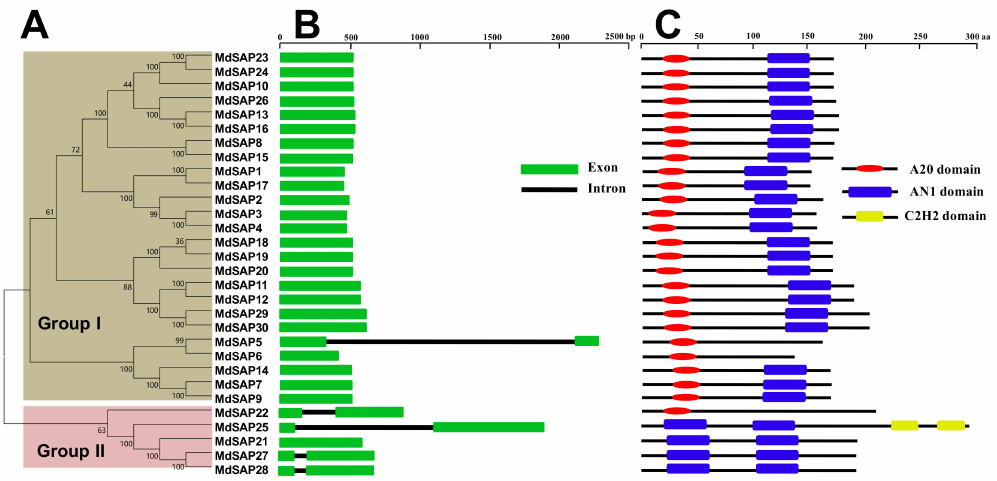
Figure 1. ( A ) Phylogenetic relationships; ( B ) Structures for 30 genes; and ( C ) Analysis of conserved domains for stress-associated protein (SAP) genes in apple. A phylogenetic tree for full-length amino acid sequences was constructed with MEGA software and the NJ